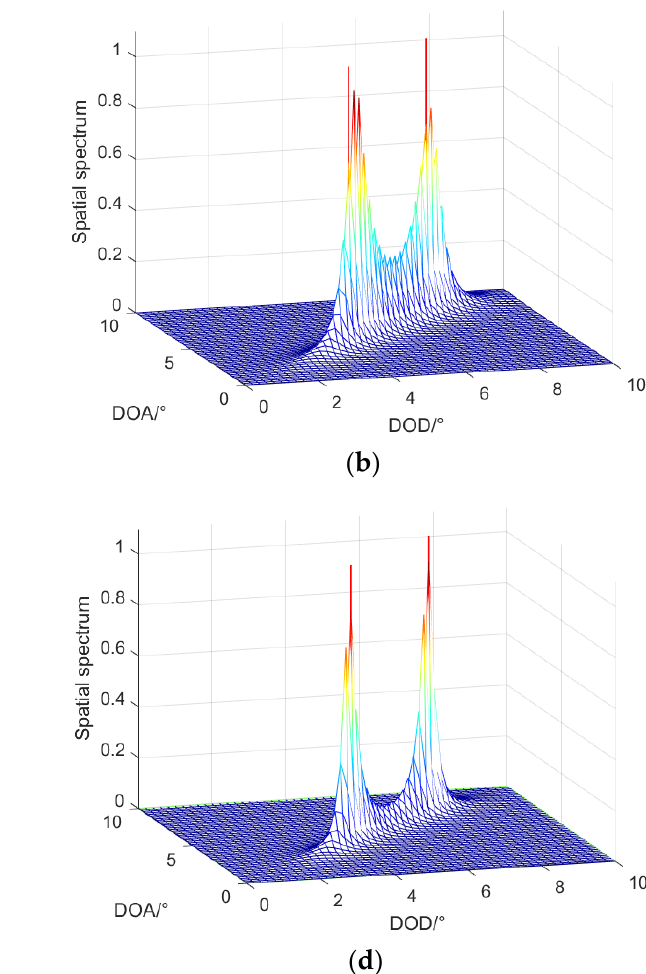
( d ) Figure 4. Results of the spatial spectral estimation of different algorithms: ( a ) LMR algorithm; ( b ) SMS algorithm; ( c ) ASDS algorithm; ( d ) TRDS algorithm. 4.3. Angular Resolution In this part, we assumed that the number of snapshots was 200 and the SNR was 10 dB. The DODs and DOAs of targets were